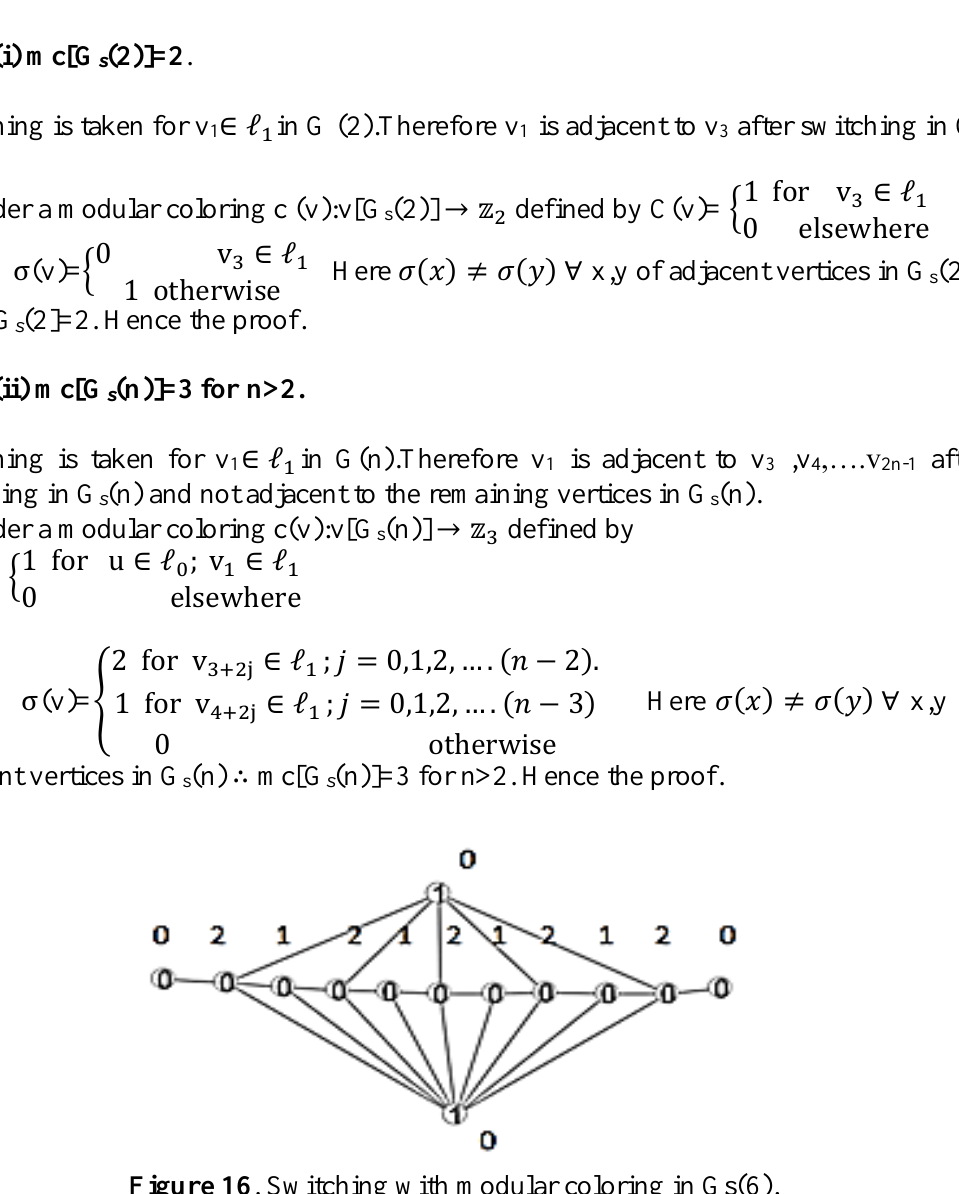
Figure 16 . Switching with modular coloring in